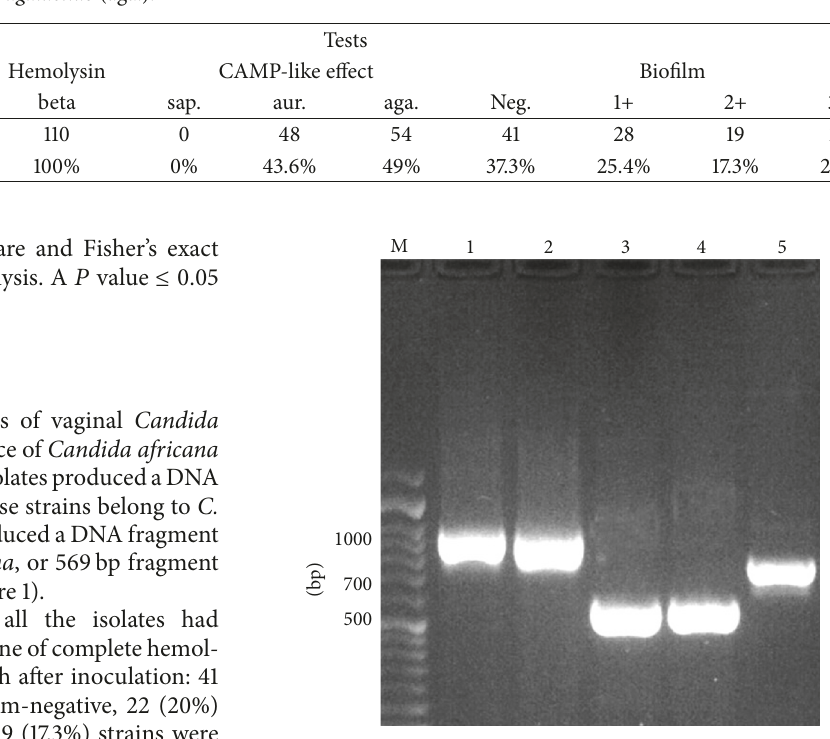
Table 1: Distribution profile of enzymatic activity, biofilm production, and CAMP-like effect on vaginal Candida albicans species isolates. S. aureus (aur.) , S. saprophyticus (sap.) , and S. agalactiae (aga.).